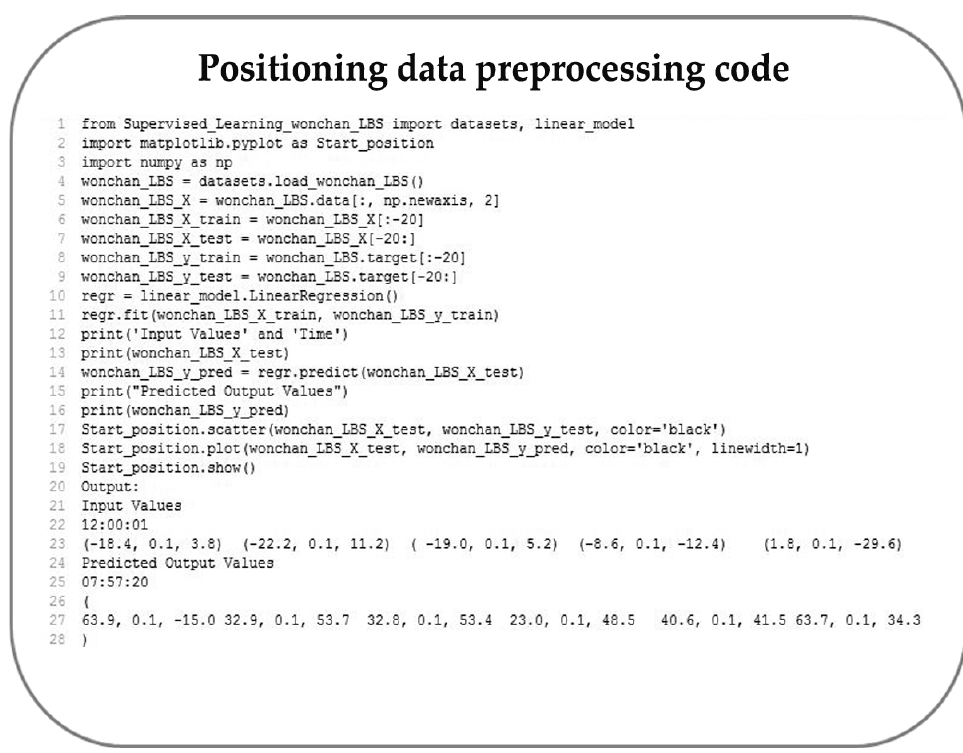
Figure 7. Sensor data collected from the scanner in the sensor network.